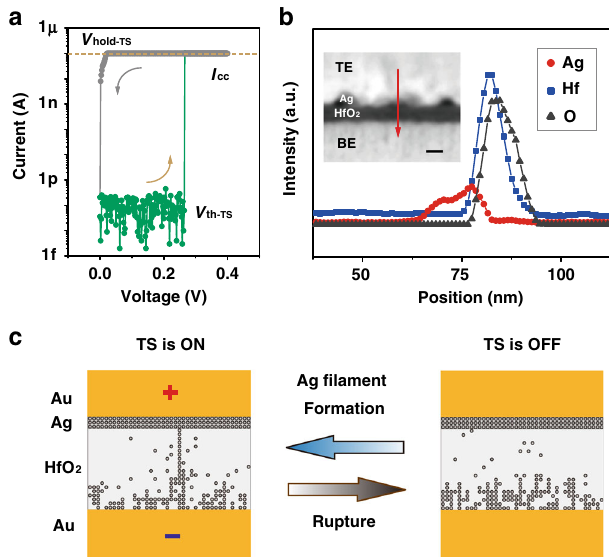
Fig. 3 Ag atomic threshold-switching (Ag/HfO 2 -based TS). a Typical I – V characteristic of the TS device at a compliance current ( I cc ) of 100 nA in forward (green)/reverse (grey) voltage sweeping, exhibiting ultralow leakage currents (<1 pA). b Energy-dispersive X-ray spectroscopy (EDS) line pro fi les (including Ag, Hf, and O elements) of the TS stack layers along the red line shown in a cross-sectional high-angle annular dark- fi eld scanning transmission electron microscopy (HAADF-STEM) image. Scale bar: 10 nm. c Simulation for the formation and rupture procedures (on/off) of the atomic Ag fi lament in the TS device with an applied voltage of 0.4